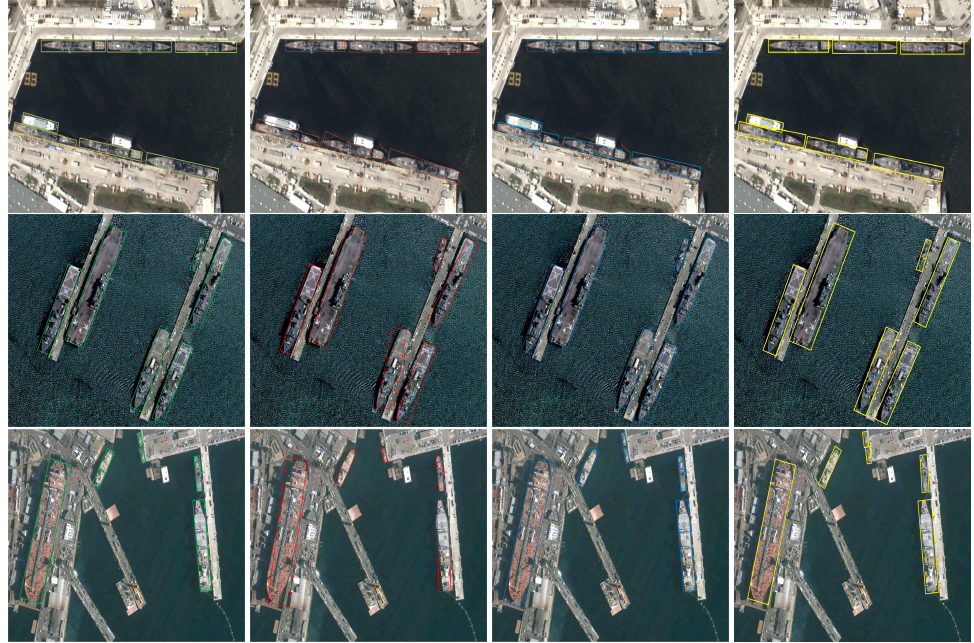
Figure 10. Comparison of ablation study methods. In the first column, we mark the ground truth with green boxes. The second column shows the detection results of Faster-RCNN OBB. The detection result in blue boxes are the effect of our use of ICR-head. In the last column, the yellow box shows the detection results used by both the DRoI module and